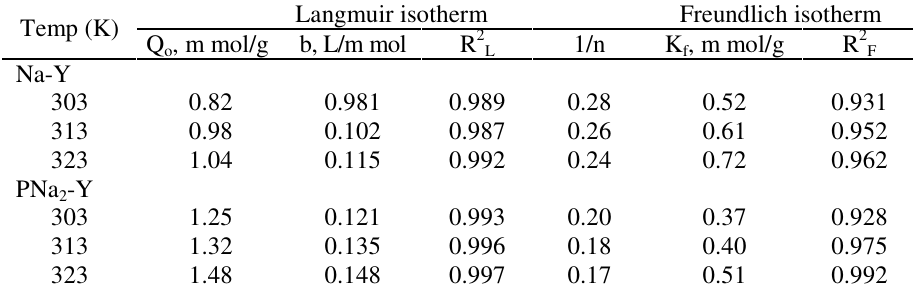
Figure 5 . Langmuir isotherm plots for the sorption of Ni 2+ ions from aqueous solutions onto (a) Na-ZSM-5 (b) PNa -ZSM-5 zeolites. 2 Table 1. Langmuir and Freundlich isotherm plots for the sorption of Ni 2+ ions from aqueous solutions onto Na-ZSM-5 and PNa -ZSM-5 zeolites. 2